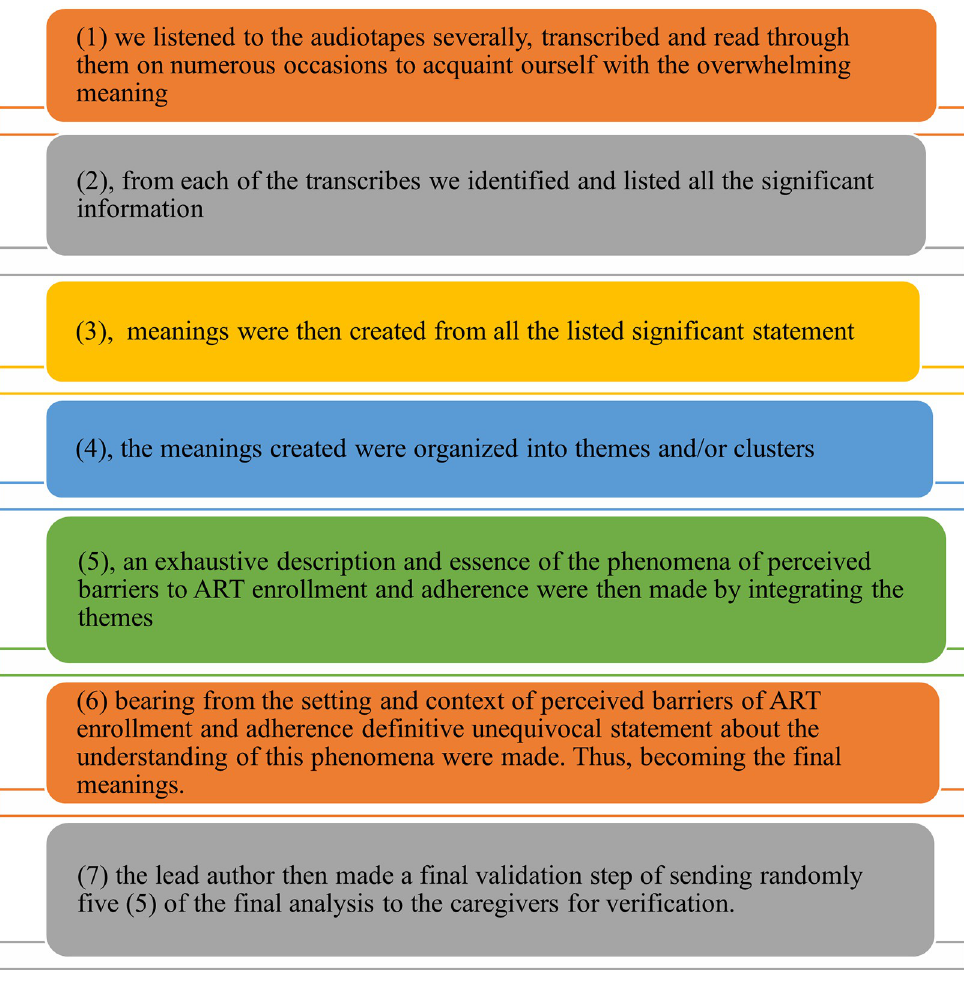
Fig 1. Collaizi steps used to analyze